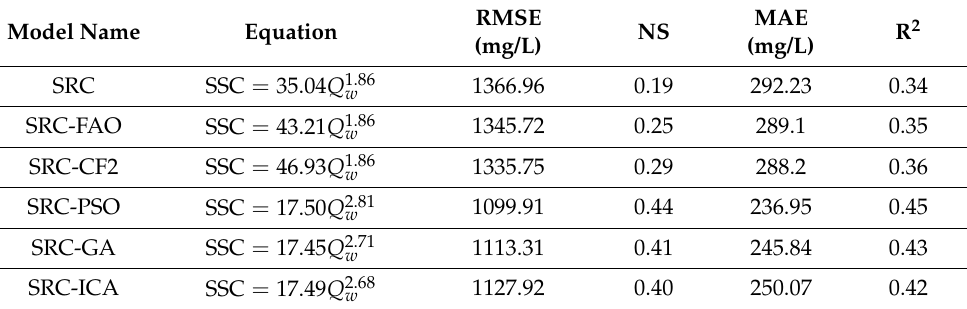
Table 6. Evaluation results for various SRC models during the testing